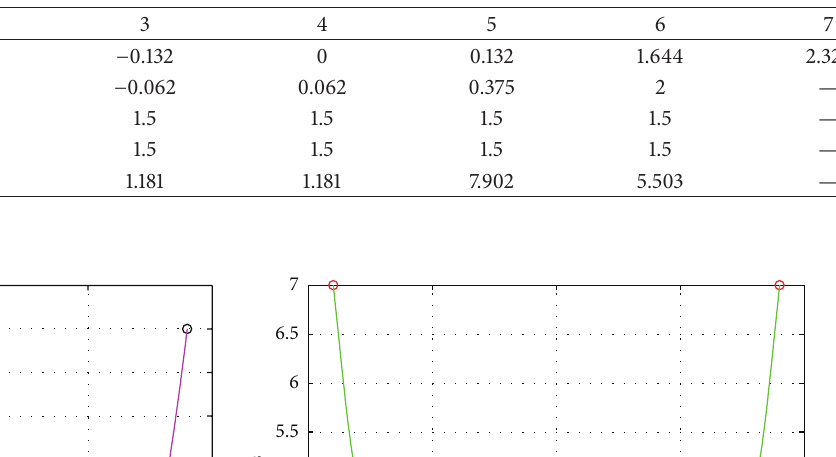
Table 6: Numerical results of Figure 3(d).